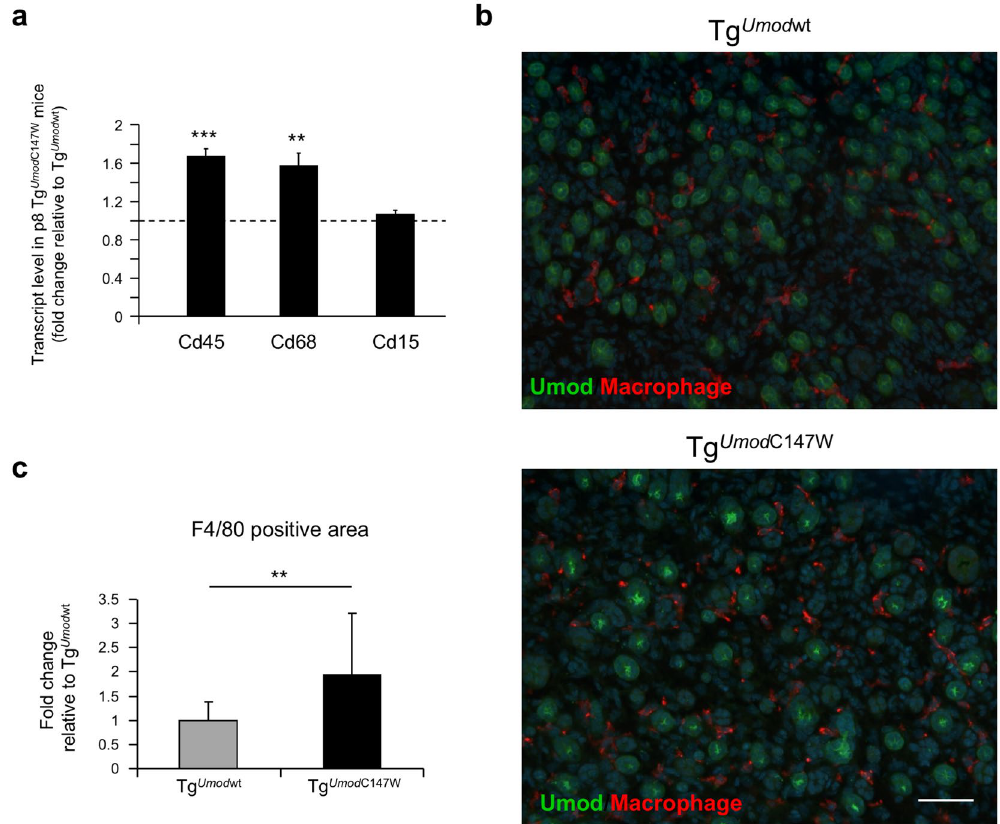
Figure 8. Inflammatory cell infiltrate in the kidneys of p8 Tg Umod C147W mice. ( a ) Analysis by RT-qPCR of markers of infiltrating cells in Tg Umod C147W mice relative to age- and sex-matched Tg Umod wt mice (n = 8 Tg Umod wt and 6 Tg Umod C147W ). As in mice at 1 month of age, Cd5 (T cells) and Cd19 (B cells) are barely detectable